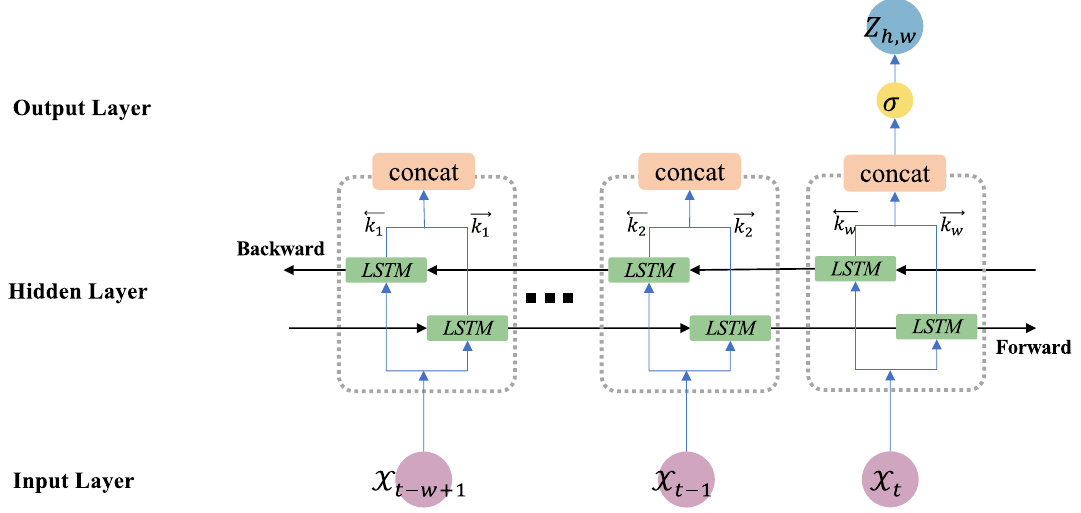
Figure 3. General BiLSTM structure for prediction horizon h using observation window of size w